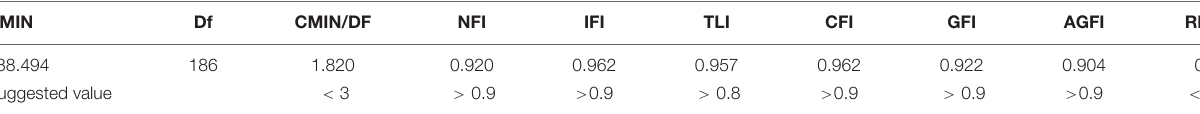
FIGURE 1 | The results of CFA. TABLE 7 | The evaluation of the goodness-of-fit of the